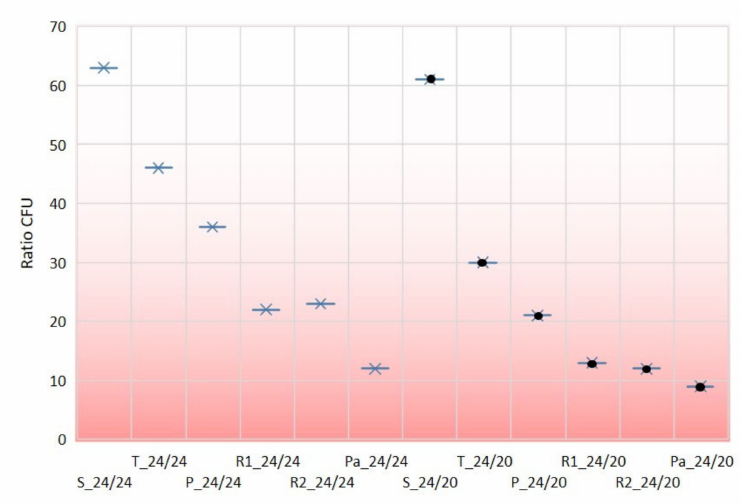
Figure 8. Ratio CFU—on the front side and on the back side. Quantity of microorganisms on fabric face as one microorganism was passed through the fabric.